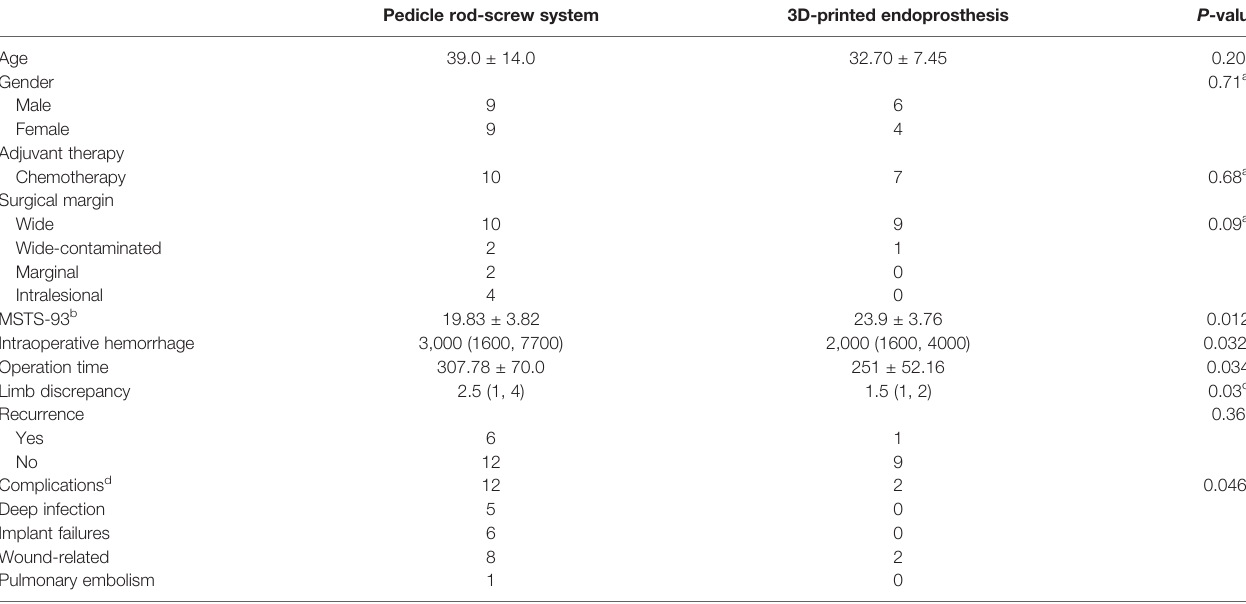
TABLE 2 | Comparison of baseline data, clinical outcomes, and complication between two